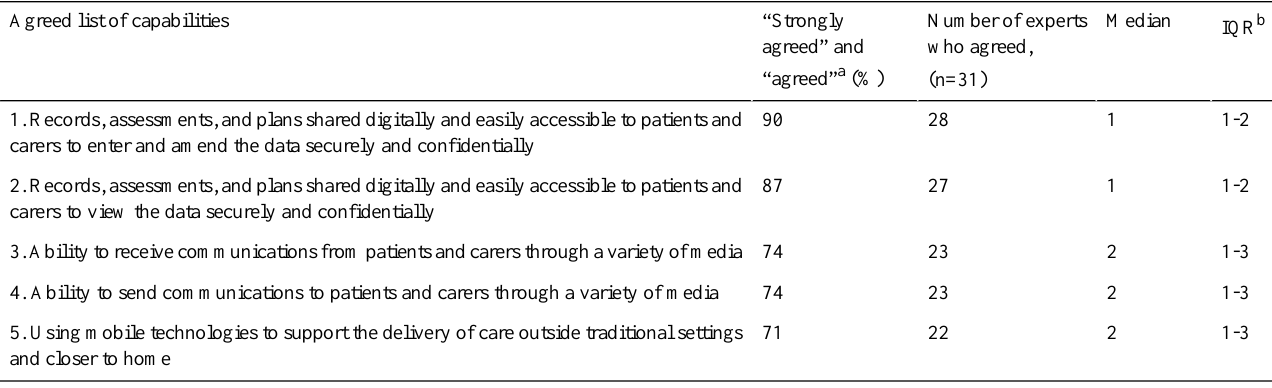
Table 4. Technological capabilities related to communication with patients and